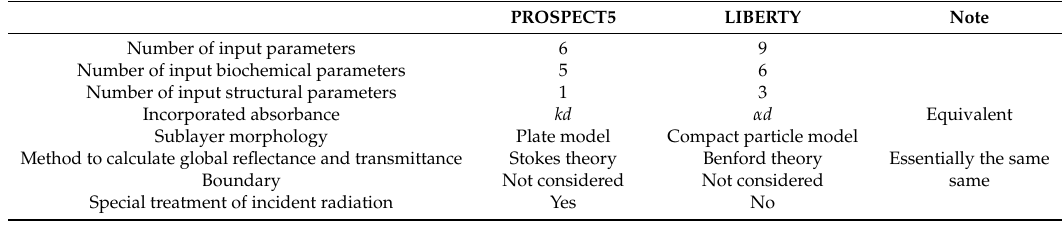
Table 3. Comparisons between Leaf Incorporating Biochemistry Exhibiting Reflectance and Transmittance Yields (LIBERTY) and The optical PROperties SPECTra model (PROSPECT5).